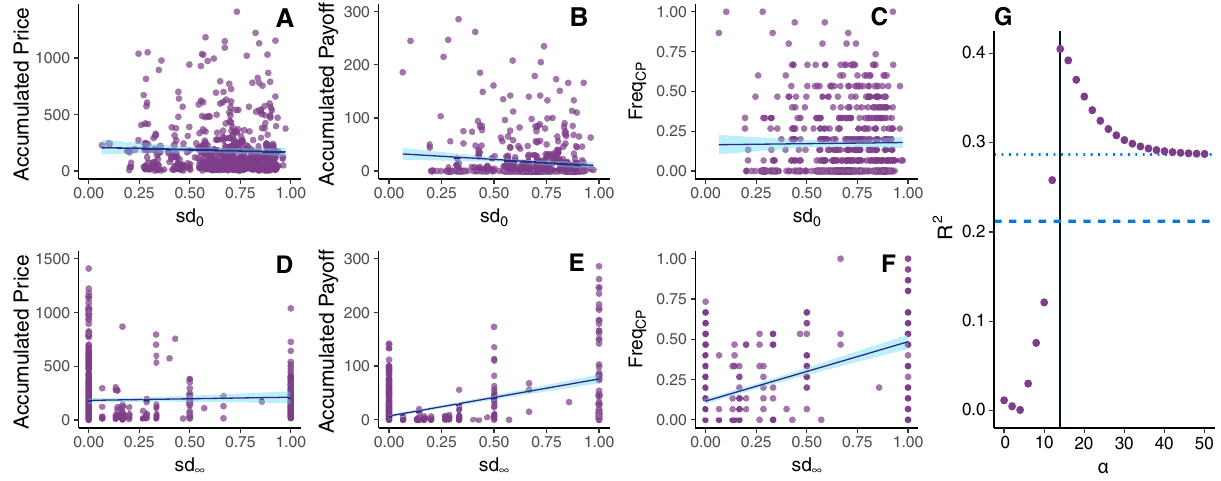
Figure 2. SD-betweenness determines payoffs but not posted prices. ( A–F ) Accumulated price ( A,D ), accumulated payoff ( B,E ) and frequency in the cheapest path ( C,F ) of participants during a series of 15 rounds as a function of the node criticallity sd 0 ( A–C ) and of the SD-betweenness sd ∞ ( D–F ). ( G ) R 2 of the regression of participants accumulated payoff on sd α versus α , where α modulates the weight of the length of the paths in the S-D centrality measure. Dashed (points) line show the value of R 2 for correlation of payoffs on the betwenness (SD-betweenness). Data is pooled across any series of 15 rounds in any experimental session. For similar analyses within each experimental network, see SI Fig. S2. Figure created using ggplot2 (v.3.2.1) 21